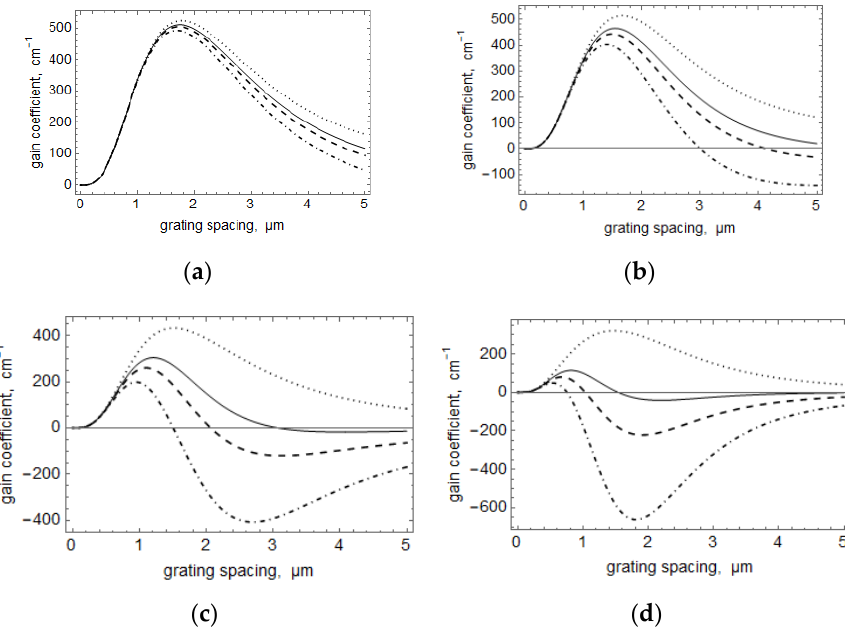
Figure 3. Gain coefficient versus grating spacing for different values of the director helix pitch: ( a ) Figure 3. Gain coe ffi cient versus grating spacing for di ff erent values of the director helix pitch: r = 2 (dotted), 0 (solid), − 1 (dashed), − 3 (dot- 2 , p L = ( b ) , p L = ( c ) / 2, p L = ( d ) / 4 p L = ; ( a ) p = 2 L , ( b ) p = L , ( c ) p = L /2, ( d ) p = L /4; r 2 = 2 (dotted), 0 (solid), − 1 (dashed), − 3 (dot-dashed); 2 r 1 = r = 1. dashed); 1